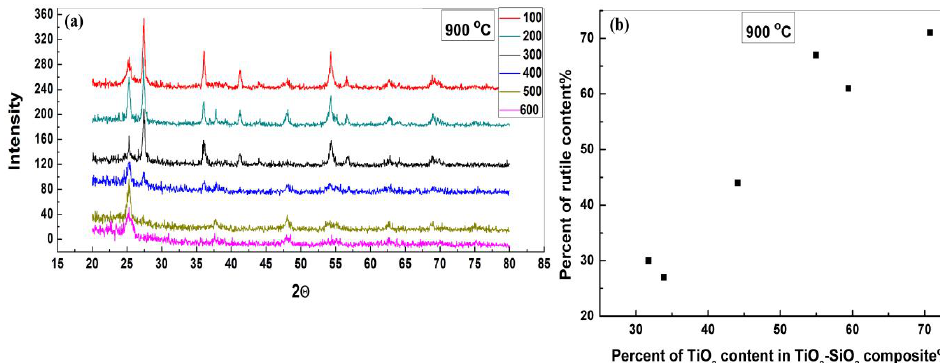
Fig. 3. (a) XRD patterns at fixed calcined temperature (900 o C) but different TiO content per TiO content. The inset table shows sample numbers correspond to TiO 2